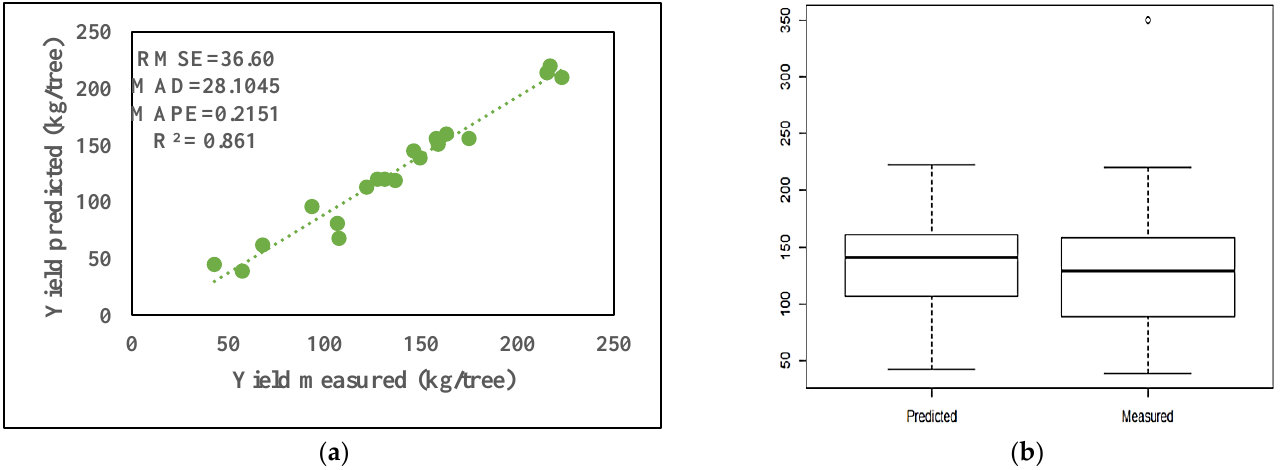
Figure 4. ( a ) Scatter plot of the measured and predicted yield of apple in the testing stage of ANN; ( b ) boxplot of measured and predicted apple yield in the testing stage of ANN. Green dots denote the observations and root mean square error (RMSE), mean absolute deviation (MAD), mean absolute percentage error (MAPE), and coefficient of determination (R 2 ) are the performance measures.